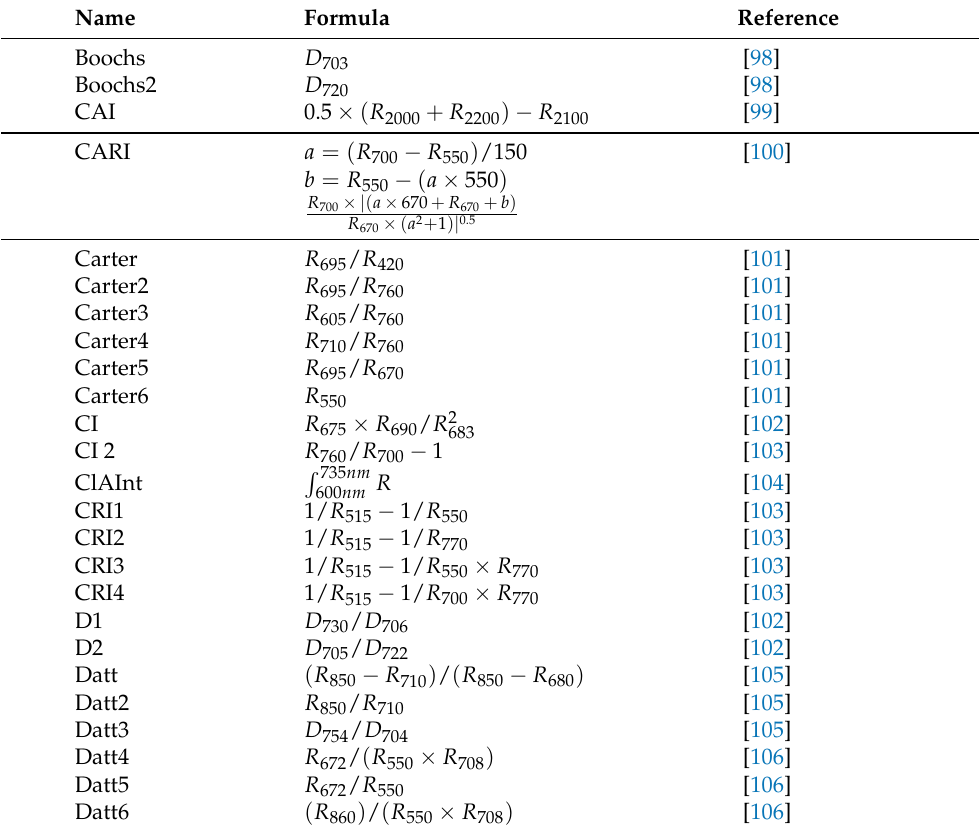
Table A2. List of available vegetation indices in the hsdar